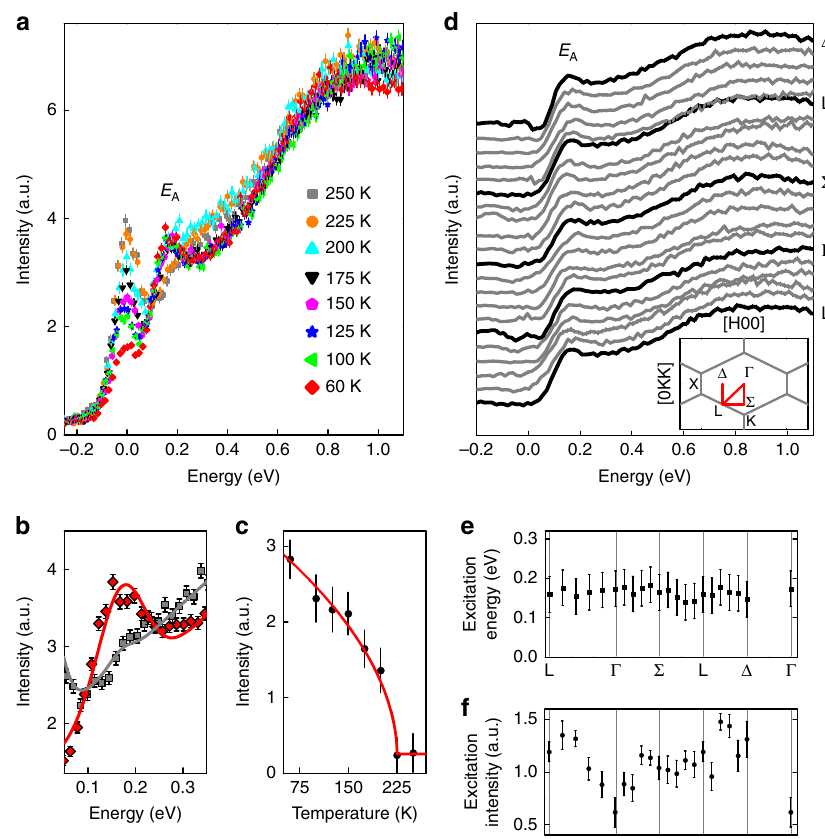
Figure 3 | Temperature and momentum dependence of excitation E A . ( a ) RIXS spectra at constant q ¼ (2.5,8.8,8.8) and fixed incident energy E i ¼ 10.877KeV at several temperatures through the magnetic MIT in Cd 2 Os 2 O 7 reveals E A as a temperature dependent excitation. ( b ) The low-energy excitation ( E A ¼ 160meV), along with the elastic line, was fit to a Gaussian on a background from the higher energy scattering at 60K (red diamonds) and 250K (grey squares). ( c ) The intensity at E A appears and increases below the magnetic MIT temperature of 225K, the line is a least squares fit to a power law. ( d ) RIXS measurements in the magnetic insulating regime at T ¼ 60K performed along high-symmetry directions in the magnetic Brillouin zone. The elastic scattering was suppressed by measuring within 4 (cid:2) of 2 y ¼ 90 (cid:2) , the remaining elastic signal has been subtracted from the data. (Inset) The Brillouin zone in the (HKK) plane is shown (grey) and the directions measured (red). ( e ) The inelastic energy and ( f ) intensity dependence of E A reveal dispersionless behaviour for E A . Error bars throughout the figure represent the s.d. in the data fitting